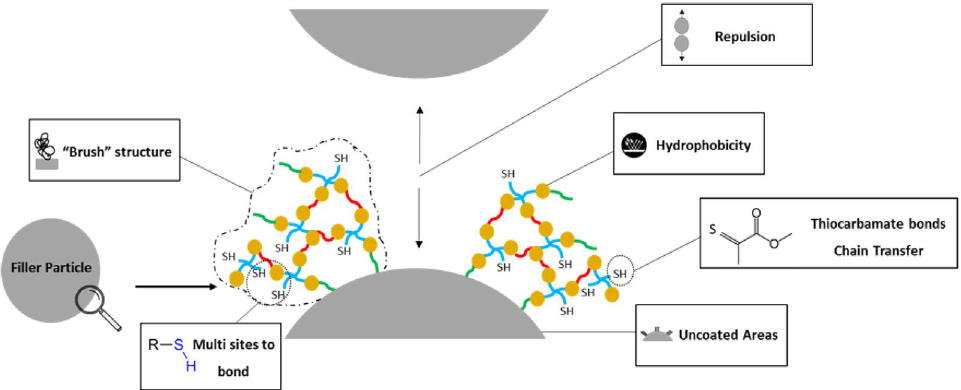
Figure 7. Schematic representation summarizing the multiple mechanisms potentially involved in the stress reduction and the toughness increase for composites containing inorganic filler particles functionalized with thiourethane